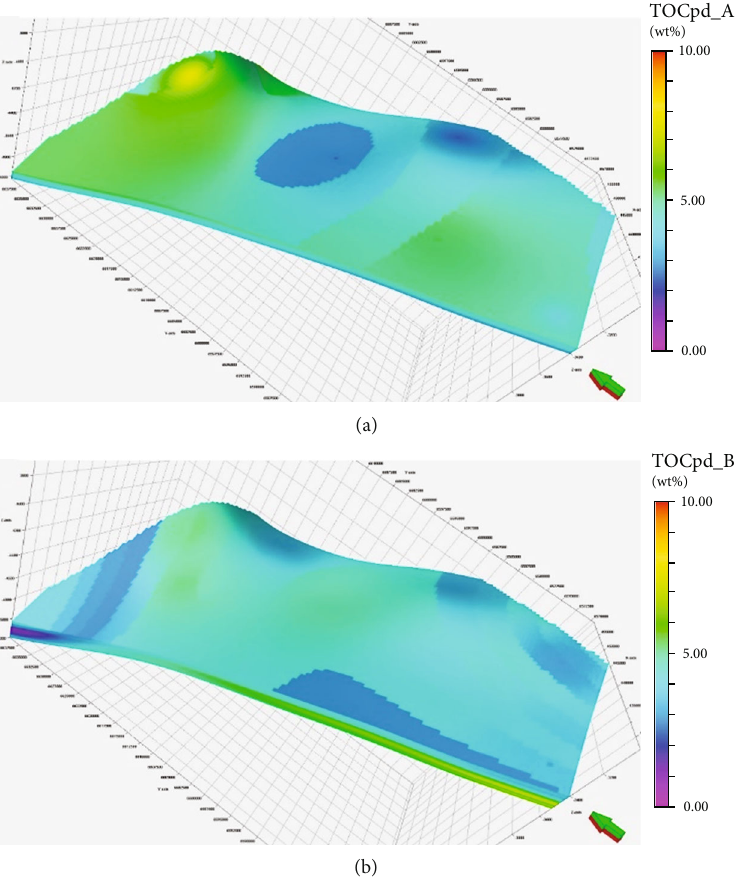
Figure 10: 3D distribution of TOCpd of the A shale bed (a) and the B shale bed (b) in the study area ( × 20 vertical exaggeration). In the A and B beds, the TOCpd between 3 and 6 weight percent is dominant in the study